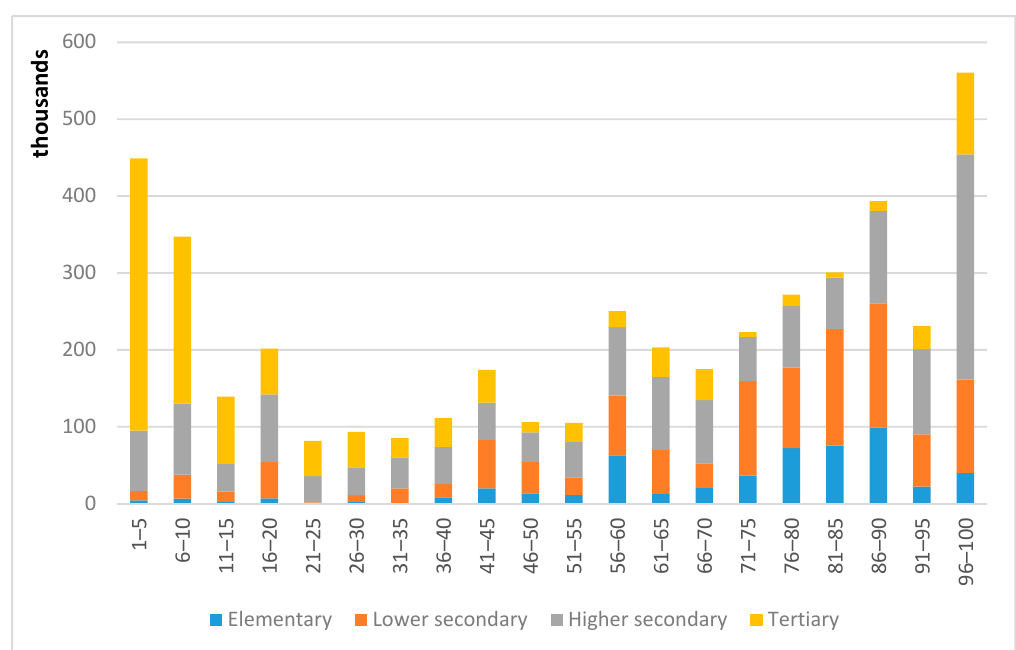
Figure 1. Breakdown of employees by susceptibility to automation and educational attainment per person in 2016. Source: Microcensus 2016. Note: International Standard Classification of Education (ISCED) categories are as follows: ISCED 0: